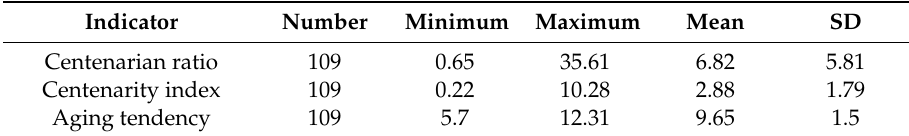
Figure 4. Spatial distribution of the three longevity indicators( A – C ) and the results ( D – F ) of the cluster and outlier analysis. Table 2. Descriptive statistics of the longevity